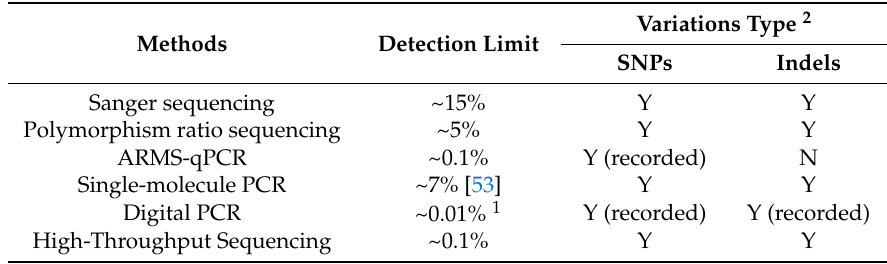
Table 1. Comparison of heteroplasmy detection